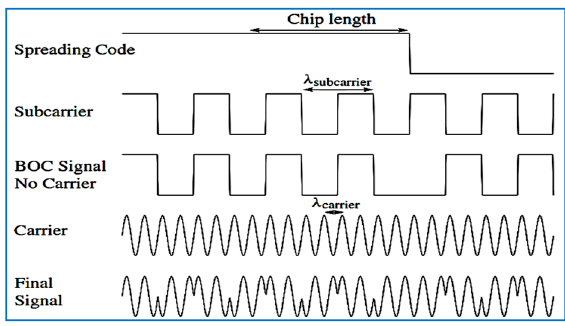
Figure 2. Spreading code, subcarrier, carrier, and signal as a result of the BOC modulation principle.